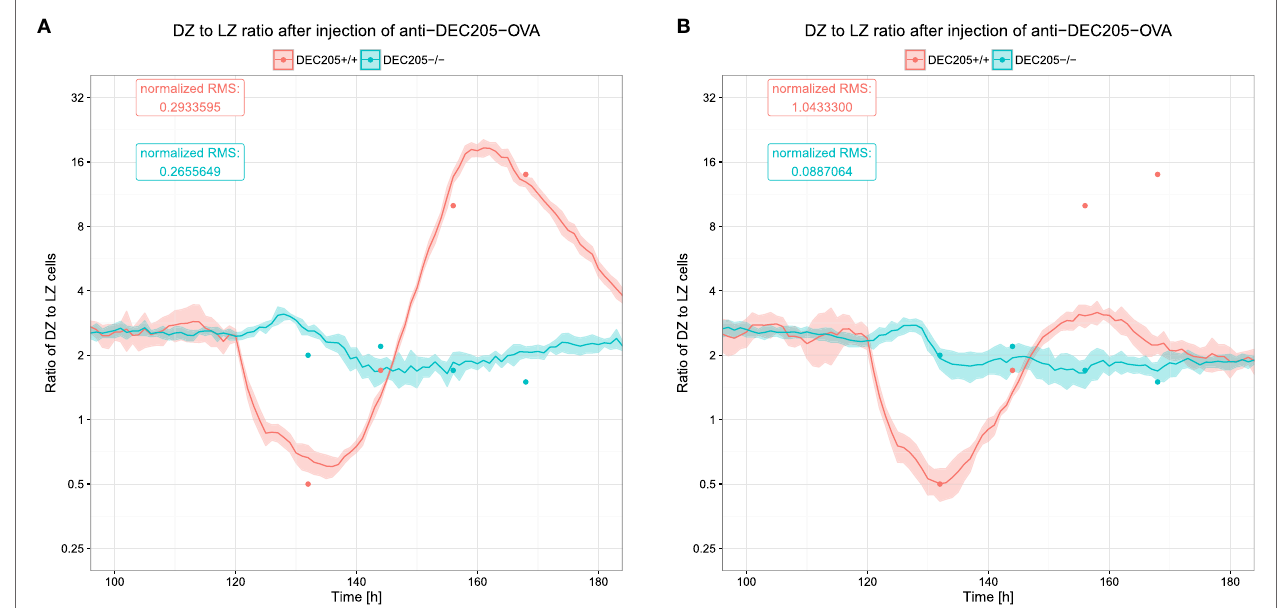
FigUre 6 | ratio of B cells in the dark zone to those in the light zone after injection of α Dec205-OVa . Dots indicate experimental measurements (8), lines and shaded area show mean and SD from 20 simulations. The two colors show the reaction of DEC205 + / + and DEC205 − / − cells. DEC205 − / − are not subjected to stimulation by α DEC205-OVA and can, thus, be expected to represent the behavior in the absence of strong antigenic stimulation. (a) DZ to LZ ratio in reference simulations with DND; (B) DZ to LZ ratio in simulations without